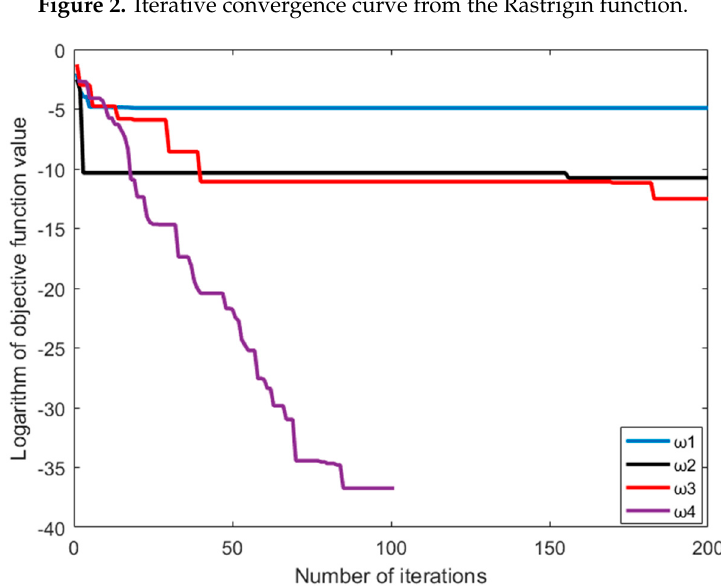
Figure 3. Iterative convergence curve from the Griewank function.